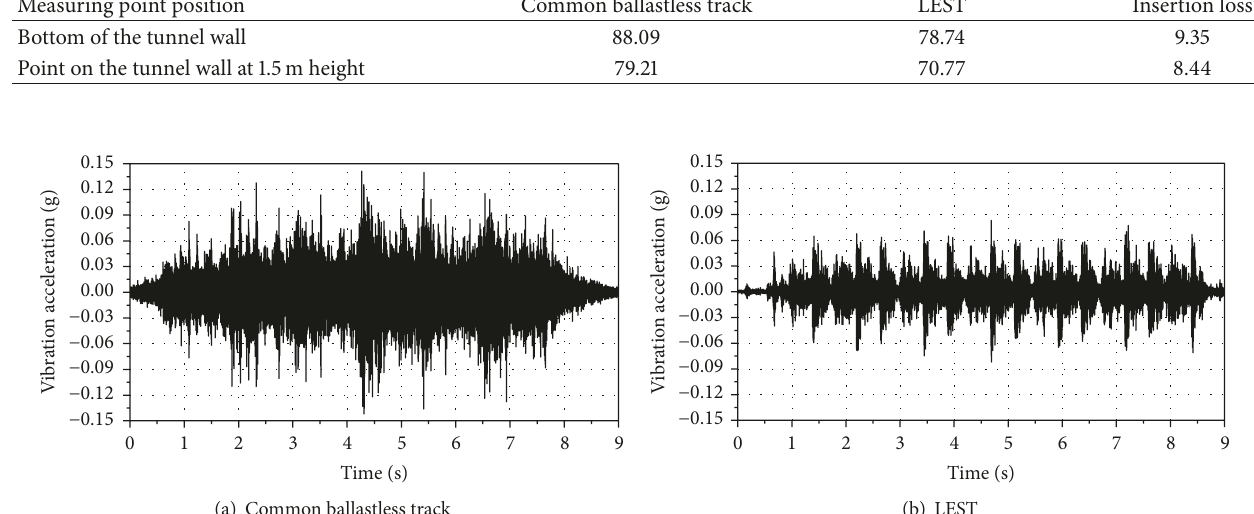
Figure 14: Typical time-history curves of vibration accelerations of point on the tunnel wall at 1.5 m height in curved track.